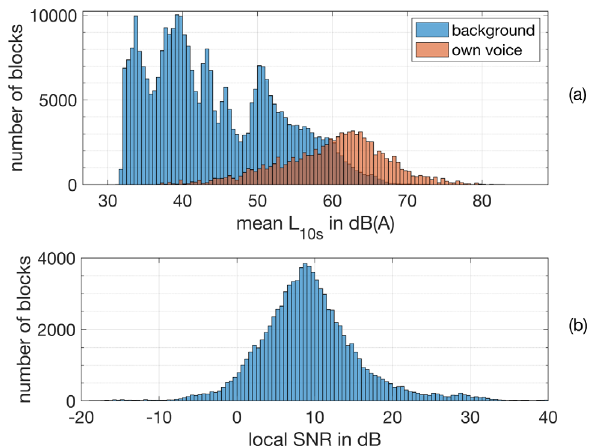
Figure 2. (a) Distribution of mean SPL for half-overlapping 10 s-intervals L 10s separated for OVS and all other sounds (background) and (b) the corresponding local SNR during the real-world recordings of one